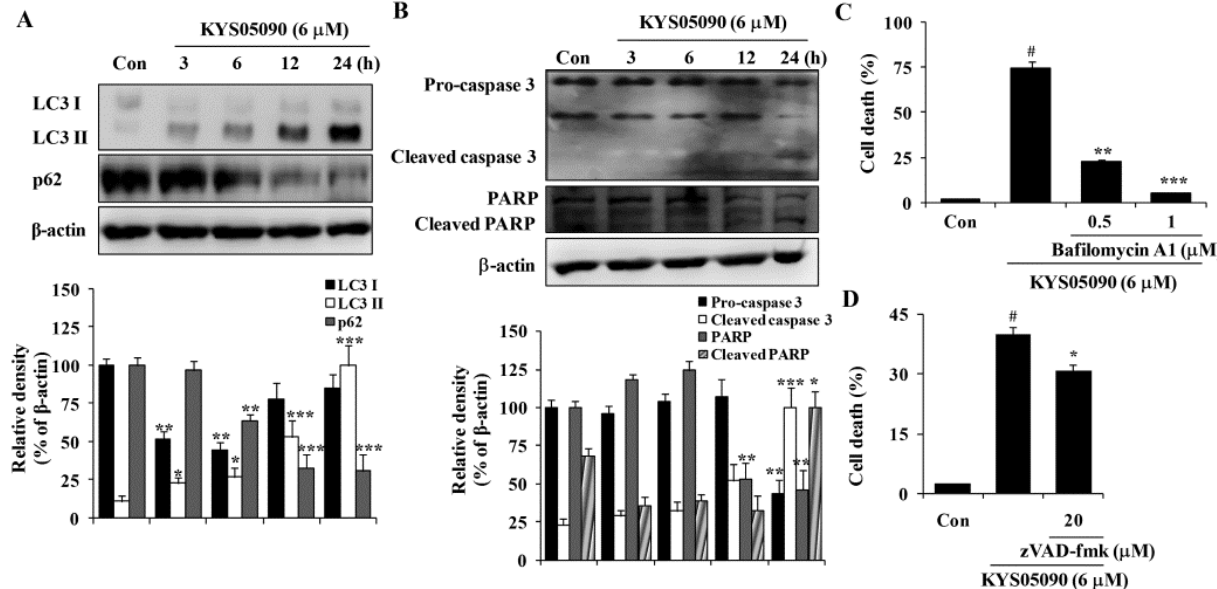
Figure 3. KYS05090 induced autophagy-associated and apoptotic cell death in A549 cells. ( A , B ) A549 cells were treated with KYS05090 (6 μM) for indicated times. The expression of proteins were analyzed by western blot analysis. β-Actin was used as an internal control. The immunoblots shown are representative of three independent experiments. Density ratios versus β-actin were measured by densitometry. * p < 0.05, ** p < 0.01, *** p < 0.001 vs. the control group ( C ) A549 cells were pretreated with bafilomycin A1 (0.5 or 1 μM) for 30 min and then treated with KYS05090 (6 μM) for 24 h. The cells were stained with PI, and cell death was analyzed by FACS. ( D ) A549 cells were pretreated with zVAD-fmk (20 μM) for 30 min and then treated with KYS05090 (6 μM) for 24 h. The cells were stained with PI, and cell death was analyzed by FACS. Presented data are means ± S.D. for three independent experiments. # p < 0.05 vs. the control group, and * p < 0.05, ** p < 0.01, *** p < 0.001 vs. the KYS05090-treated